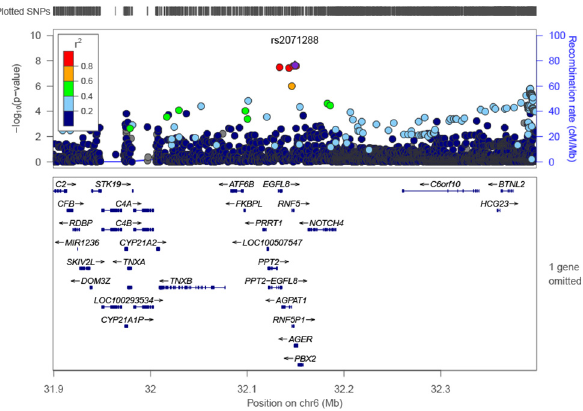
Fig 4. Regional association plot for genome-wide significant locus ( AGER ) in blacks.